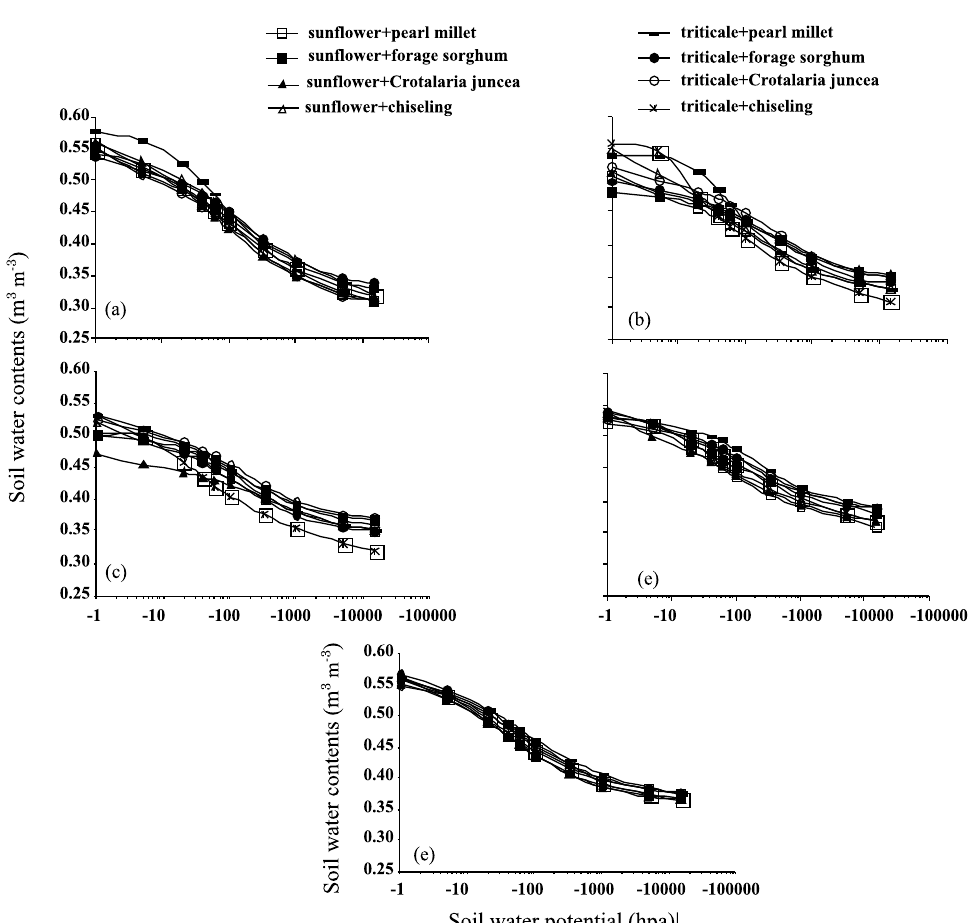
Figure 2. Soil water retention at the end of the first year of the experiment (2003/2004), as affected by crop rotation, chiseling and soil depth. (a) 0–0.05 m; (b) 0.075–0.125 m; (c) 0.15–0.20 m; (d) 0.275–0.325 m and (e) 0.475–0.525